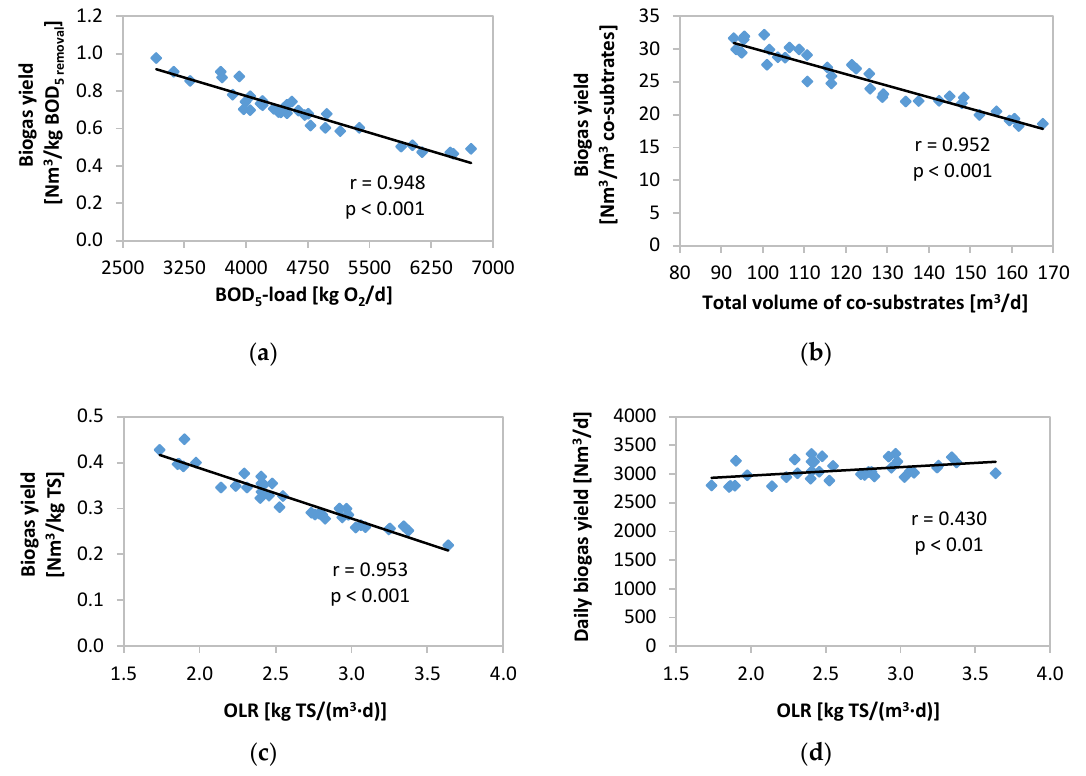
Figure 11. Influence of technological parameters on the daily biogas yield. Dependence between: ( a ) BOD 5 in the influent and the biogas yield; ( b ) total volume of co-substrates and the volumetric biogas yield; ( c ) OLR of the digester and the biogas yield; ( d ) OLR of the digester and the daily biogas yield.